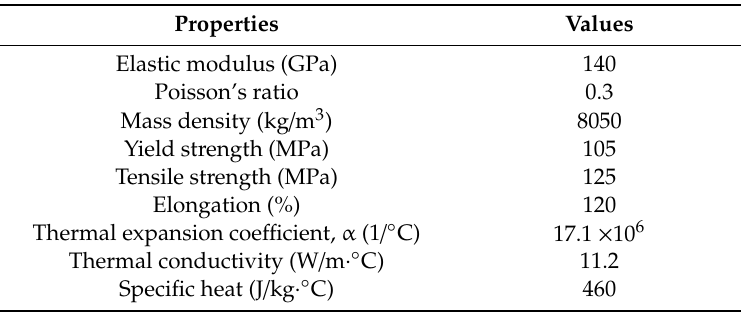
Table 1. Mechanical and thermal properties of INCONEL 601 at 900 °C.